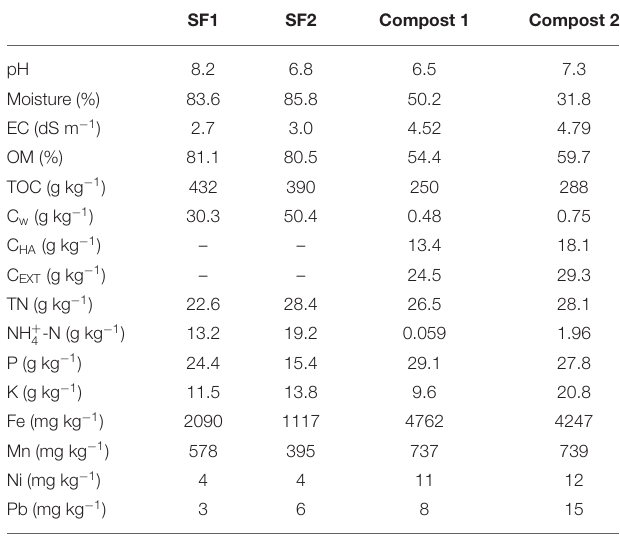
TABLE 1 | Characteristics of the composts and the solid fractions of pig slurry used for composting (SF1 and SF2).